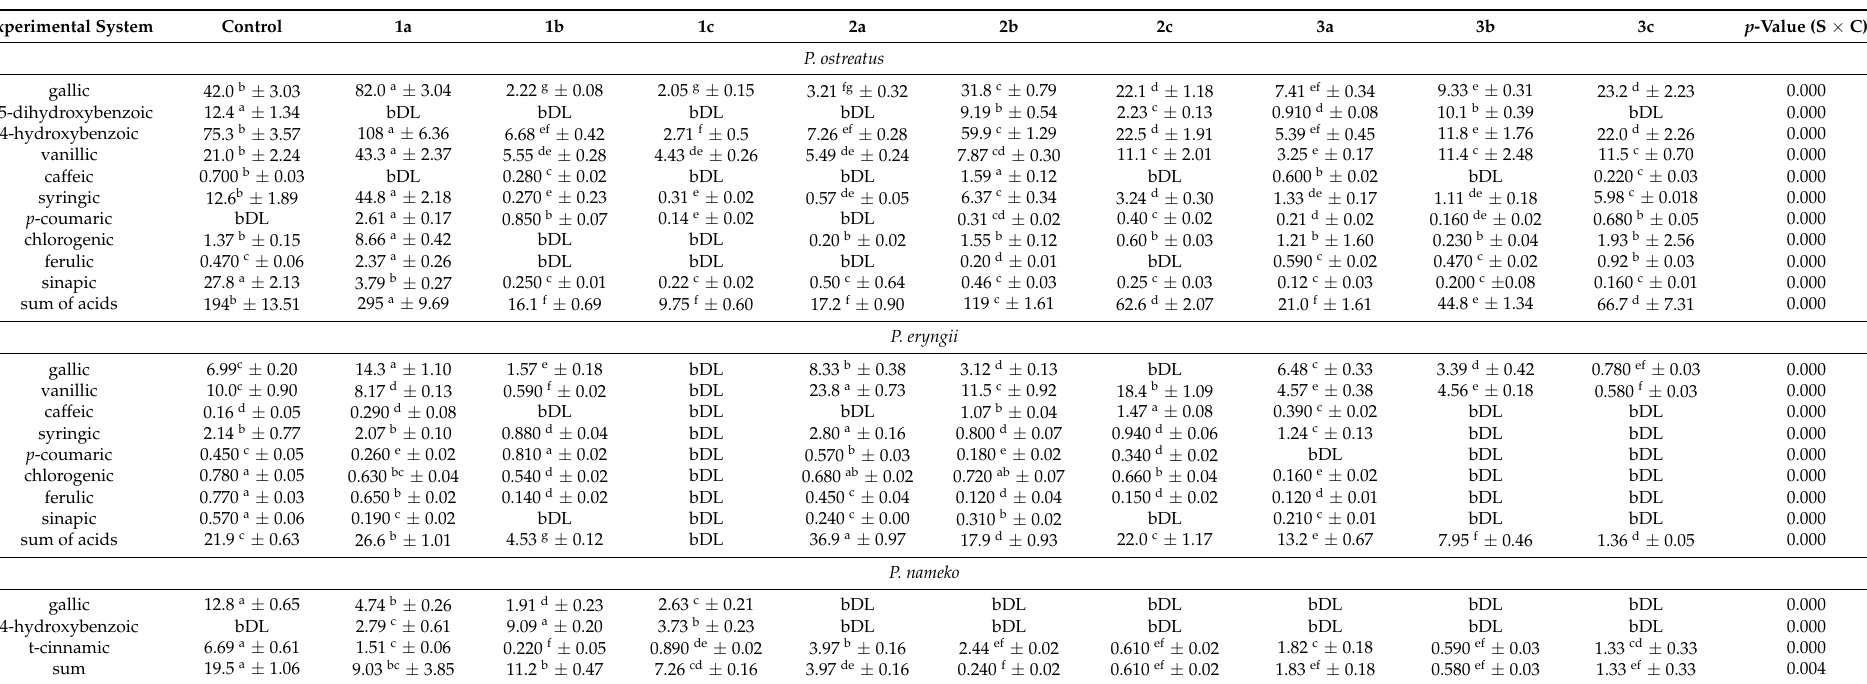
Table 4. Phenolic acids profile ( µ g g − 1 DW) of fruiting bodies of the mushroom species under different Fe salts supplementation and concentrations (mean value ± standard